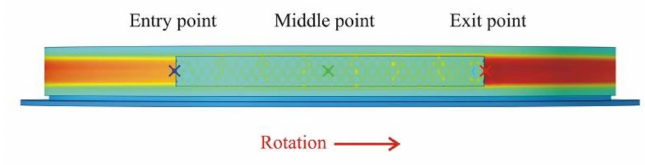
Figure 6. Location of the three points of the Cut Point 3D type.